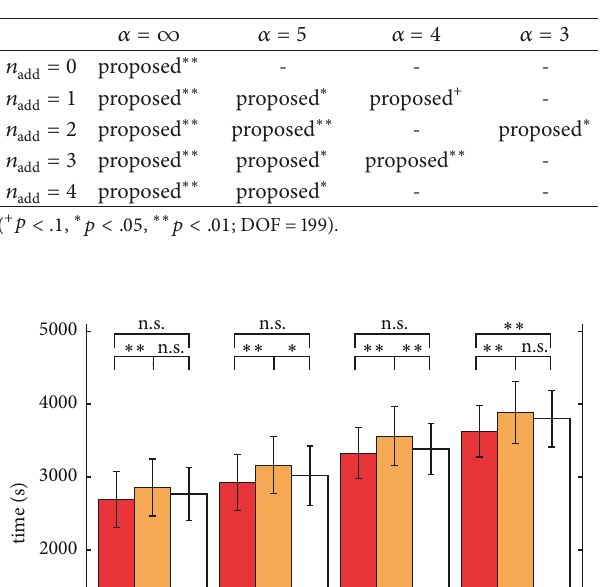
Table 9: Comparison between proposed method and full searching (with an unreasonable agent).